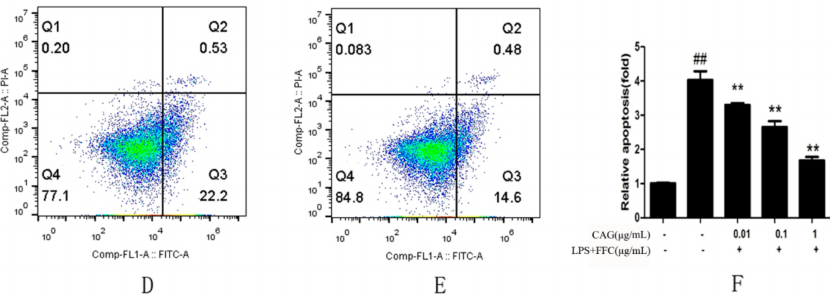
Figure 2. The rate of apoptosis ( A ) the control group; ( B ) the model group; ( C ) the 0.01 µ g/mL CAG group; ( D ) the 0.1 µ g/mL CAG group; ( E ) the 1 µ g/mL CAG group; ( F ) comparison of apoptosis rates in each group. # p < 0.05, ## p < 0.01 compared to the control; * p < 0.05, ** p < 0.01 compared to the model